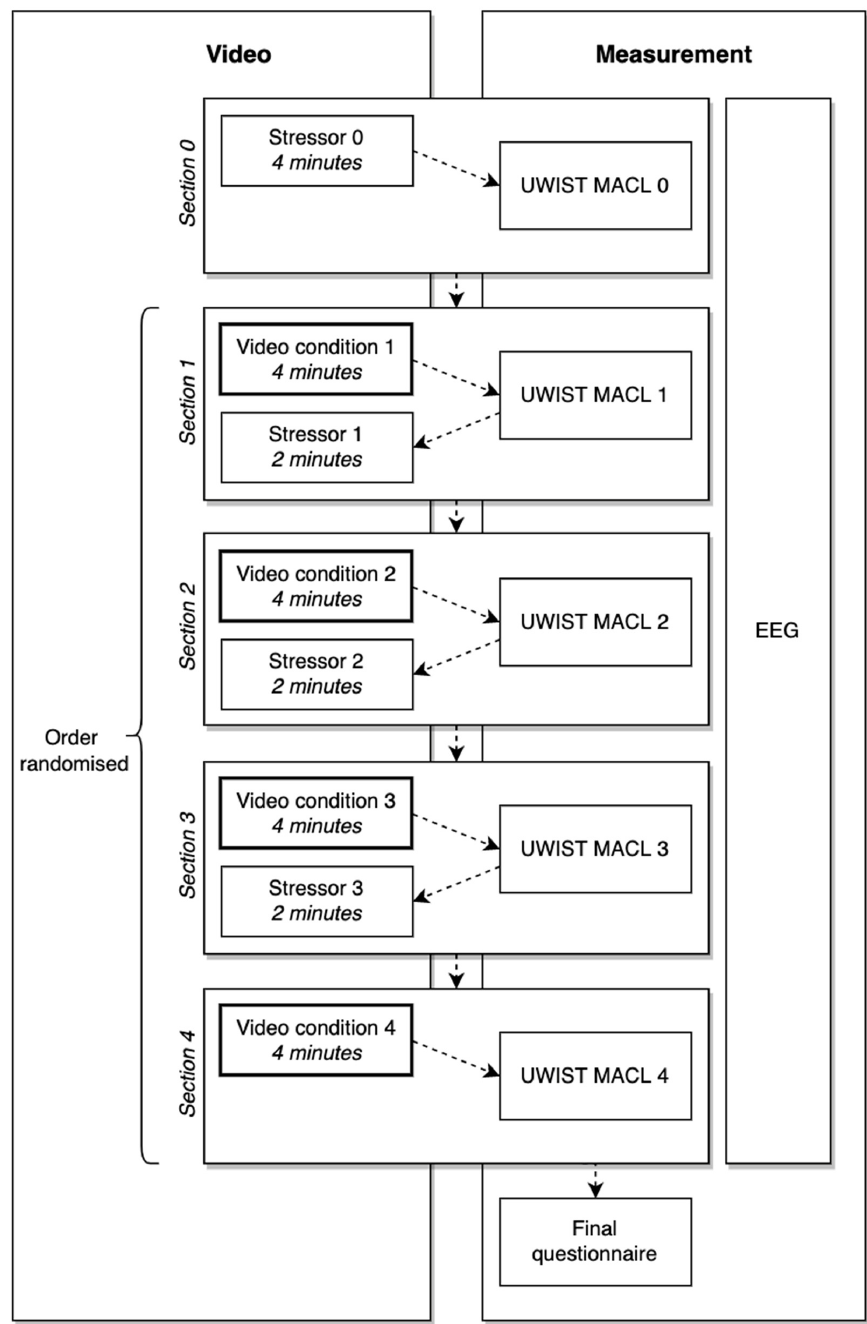
Figure 3. Experiment procedure.